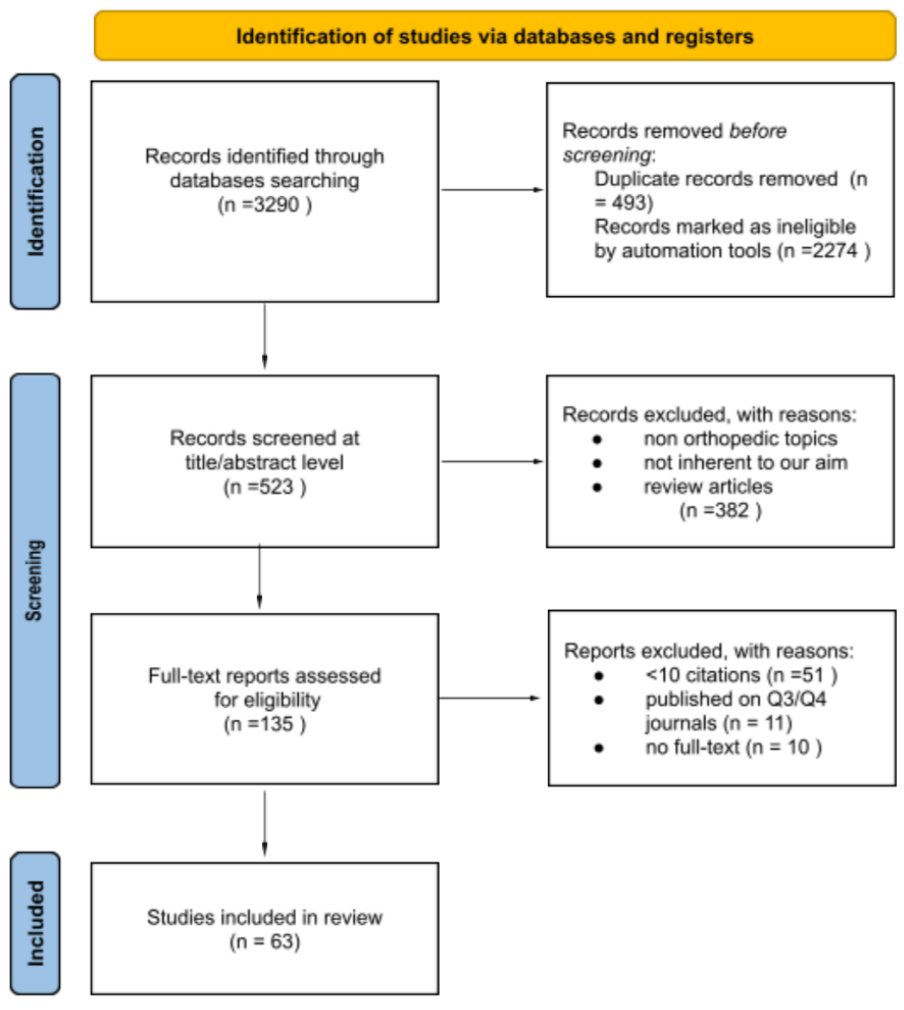
Figure 1. Flowchart representing the screening process of the papers. The flowchart is structured according to the available PRISMA